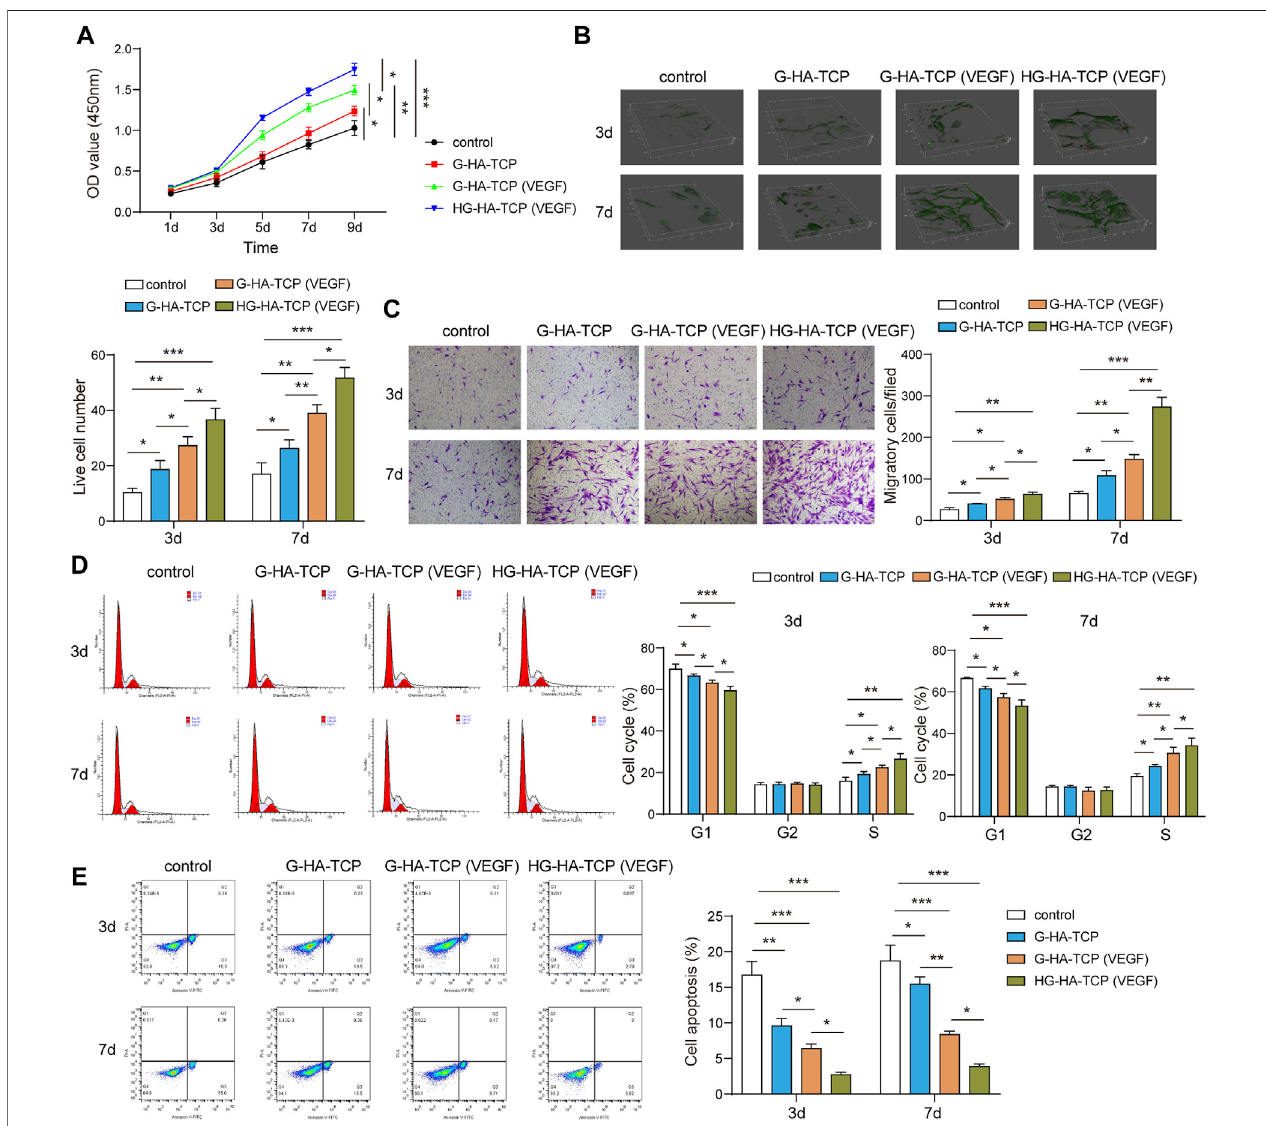
FIGURE4| Biocompatibilityofscaffoldmaterials. (A) CellproliferationwasdetectedusingCCK-8assay. (B) CellsurvivalwasassessedusingLIVE/DEADassay. (C) Transwell assay was performed to measure cell migration. (D,E) Flow cytometry was performedfor the detection of cell cycle and apoptosis n = 3. * p < 0.05, ** p < 0.01, *** p <